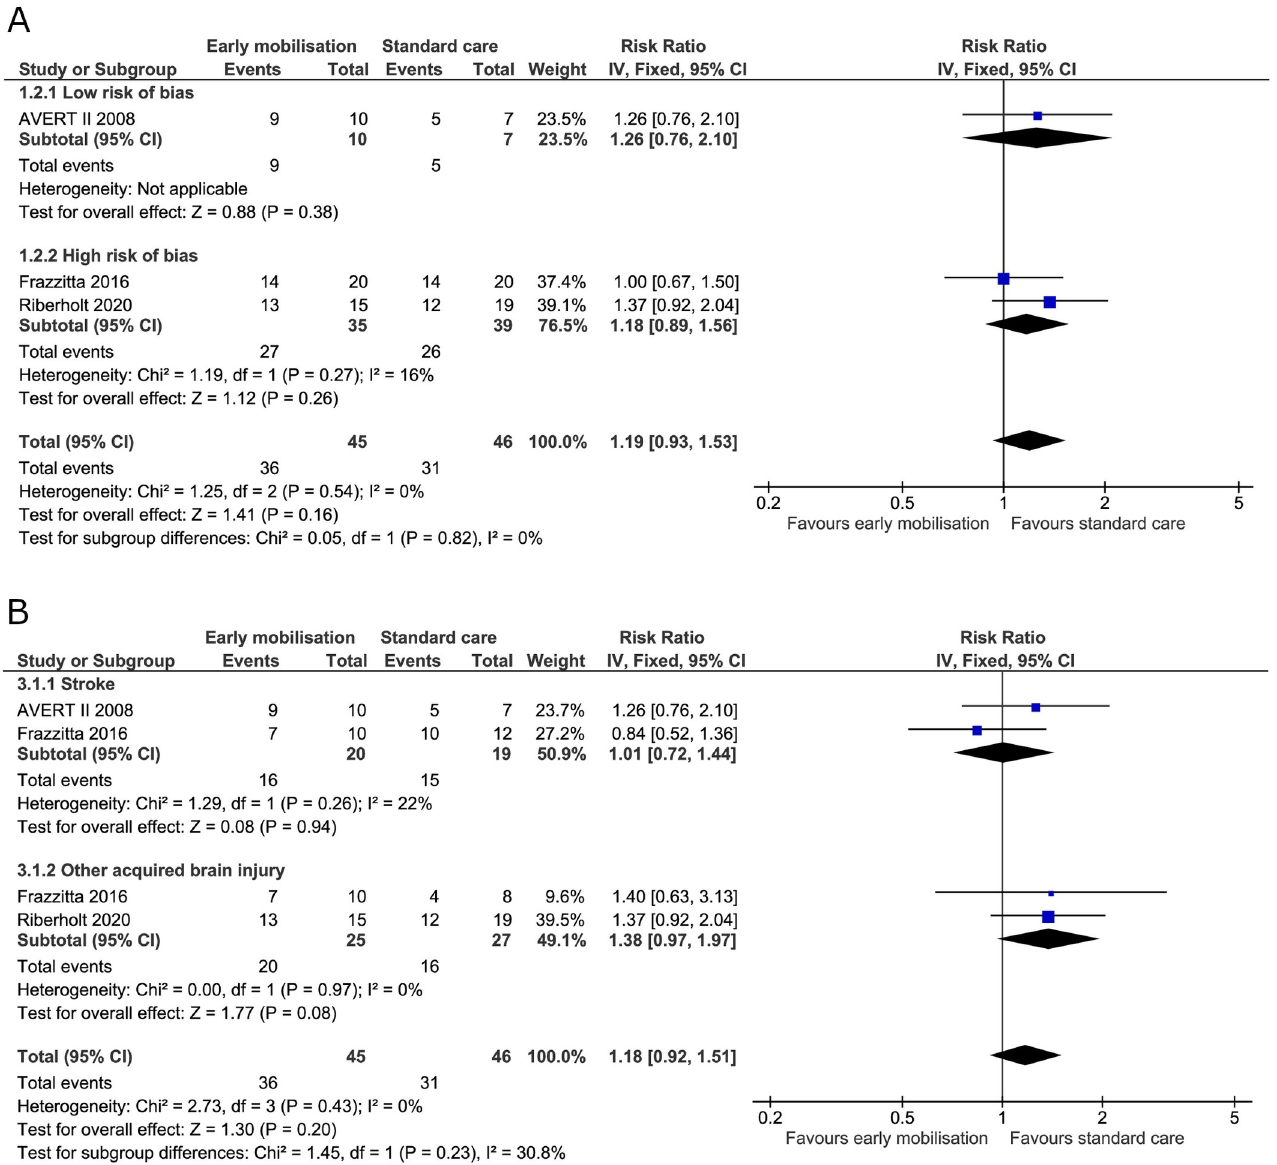
Fig 4. Comparison of early mobilisation versus standard care–mortality or poor functional outcome at the end of the intervention. Fig 4A and 4B. Forest- plots showing the results from the fixed-effect meta-analysis of the primary composite outcome mortality or poor functional outcome at the end of intervention with subgroup divided according to risk of bias (A) or diagnosis